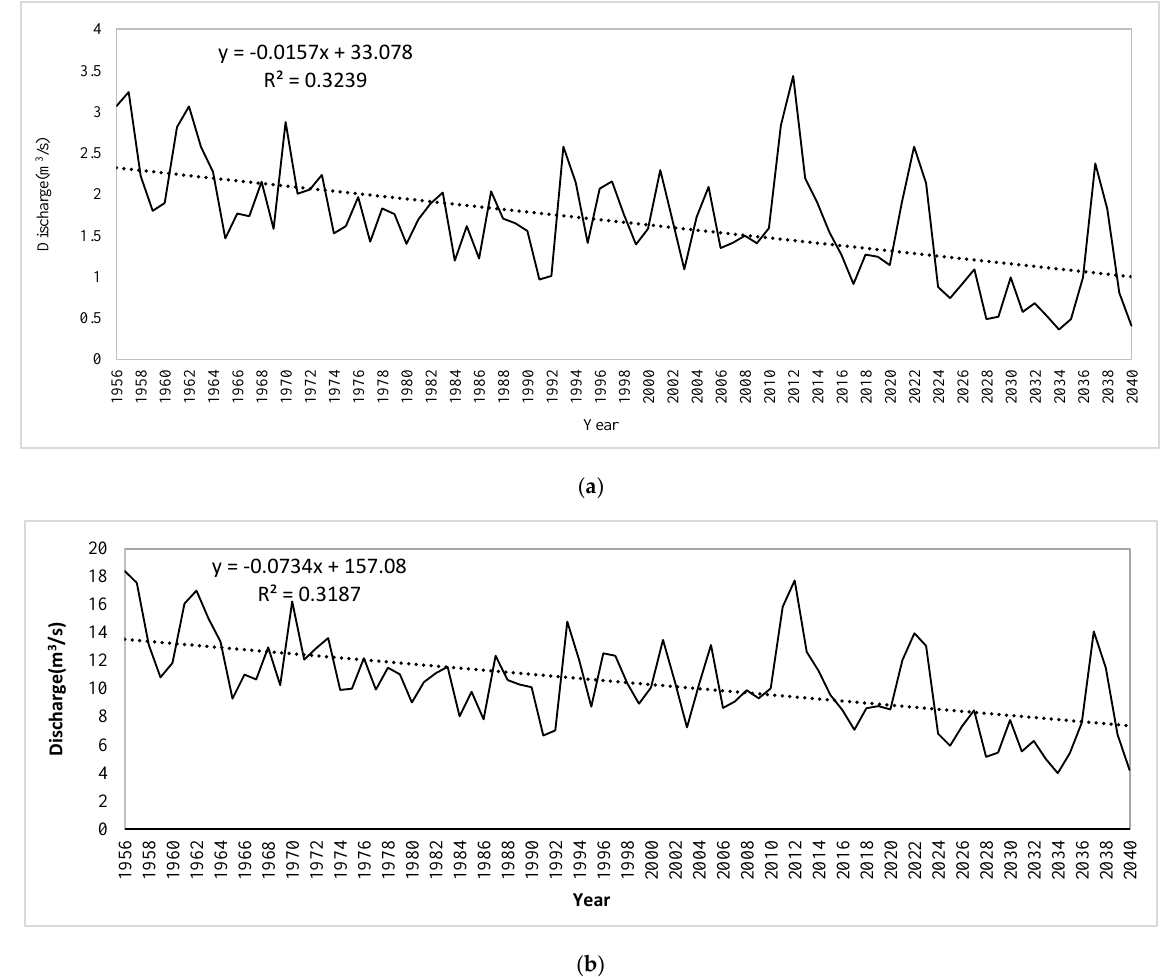
Figure 8. Long term average flow (1956 – 2040) (m 3 /s) for Sebwe ( a ) and Mubuku ( b ).